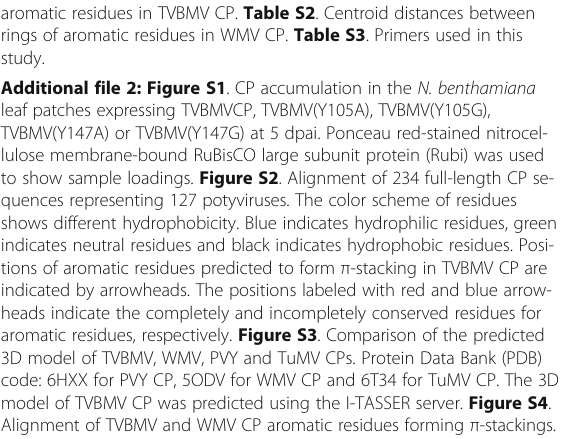
Additional file 1: Table S1 . Centroid distances between rings of aromatic residues in TVBMV CP. Table S2 . Centroid distances between rings of aromatic residues in WMV CP. Table S3 . Primers used in this study. Additional file 2: Figure S1 . CP accumulation in the N. benthamiana leaf patches expressing TVBMVCP, TVBMV(Y105A), TVBMV(Y105G),